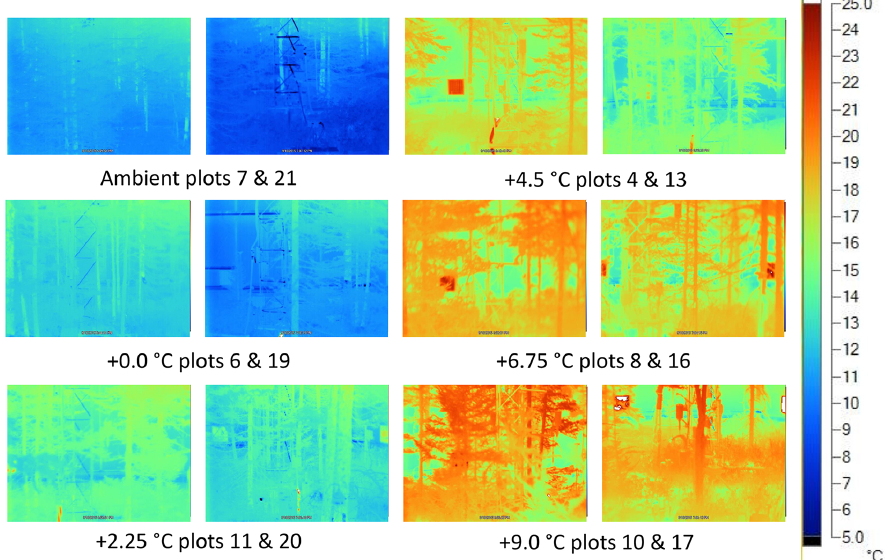
Figure 6. Color infrared images for the space within the designated treatment enclosures taken on 10 September 2015 after sunset within a 30min period. The thermal color scale in ◦ C applies to all images. Non-biological metal or plastic surfaces in the images may not provide an accurate temperature due to their emissivity difference from biological surfaces.